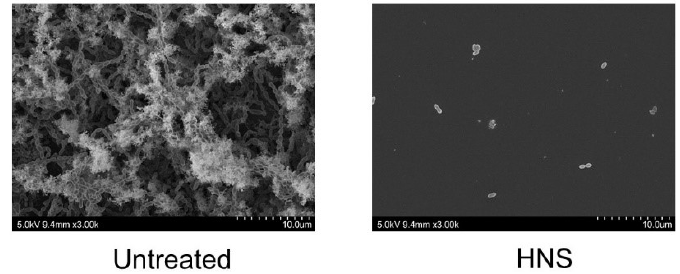
Figure 4. Inhibitory effects of the HNS on the biofilm formation by S. mutans , measured by scanning electron microscopy (SEM). S. mutans cells were treated with HNS (500 μg/mL) for 48 h. The samples were examined by SEM.